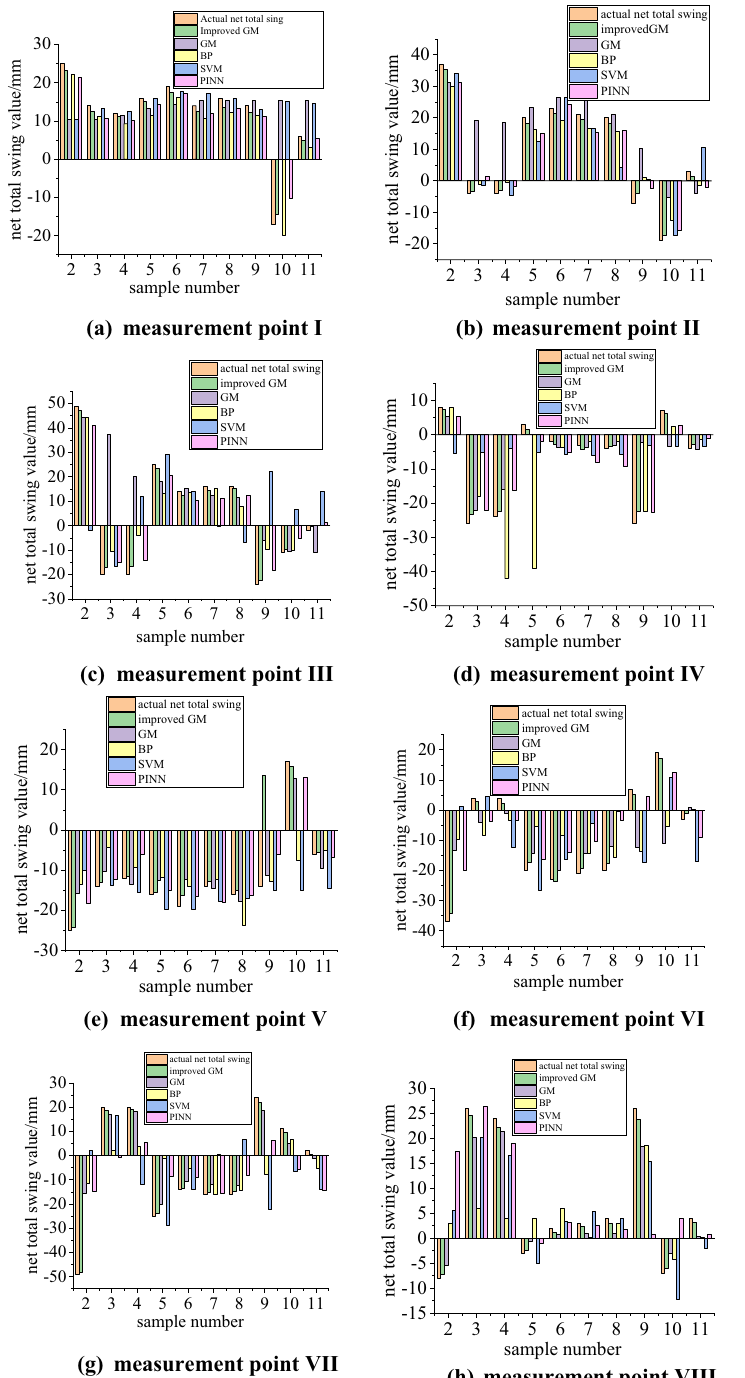
Figure 7. Comparison of predictions by the